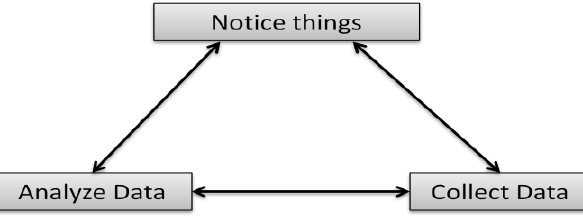
Figure 1: Workflow of Qualitative Data